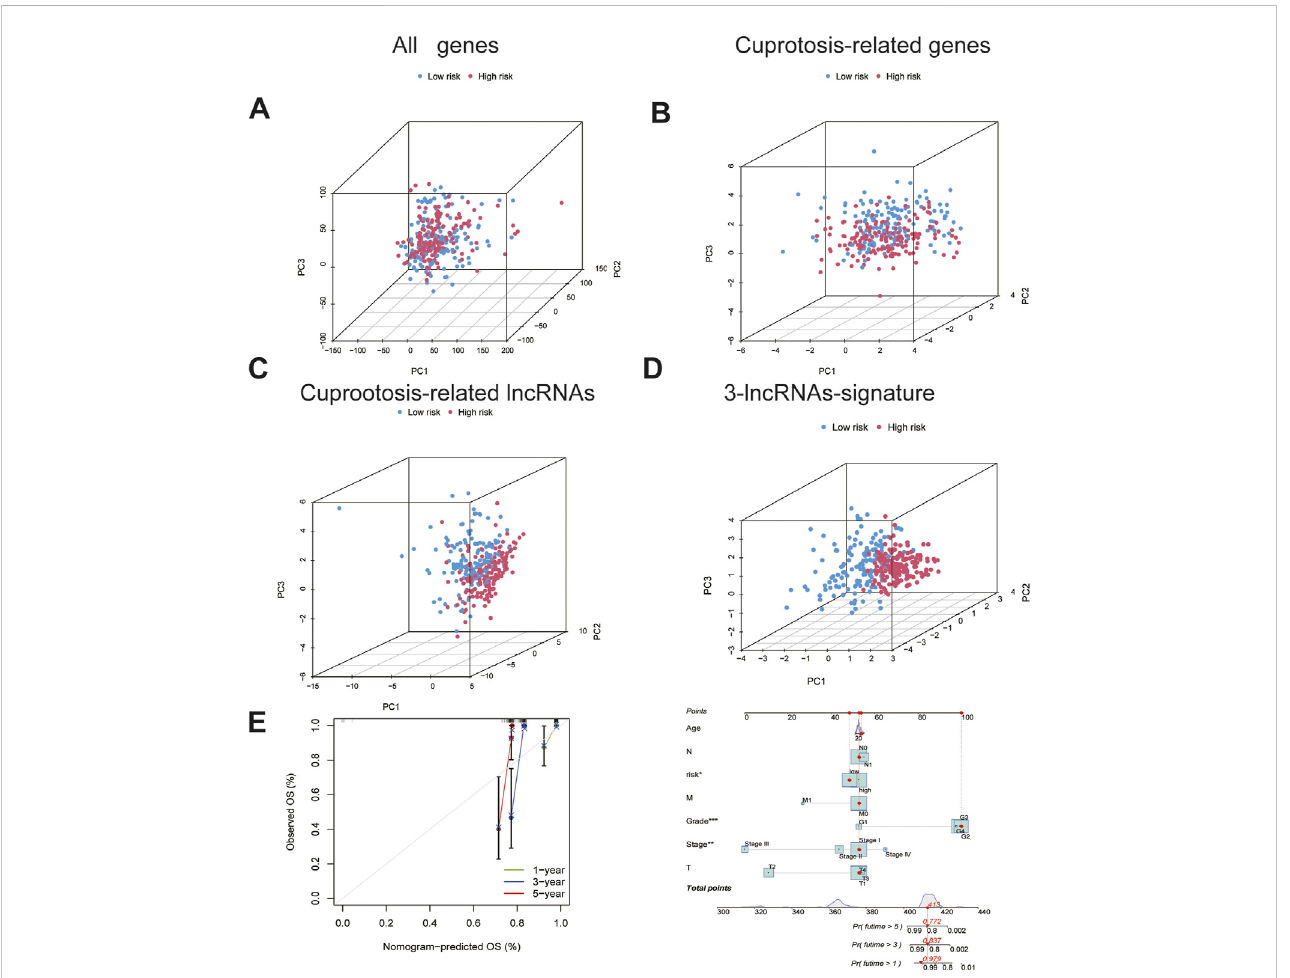
FIGURE 4 ThePCAandnomogramofthesignature. (A) .PCAofallgenes. (B) PCAofcuproptosis-relatedgenes. (C) PCAofcuproptosis-relatedlncRNAs. (D) PCAof3- lncRNA signature (risk DE-lncRNAs). (E) The nomogram of 3-lncRNA